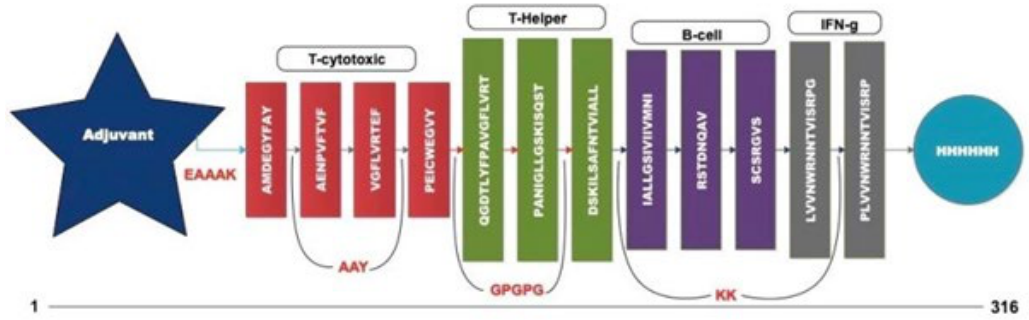
Fig. 4. Multi-epitope vaccine construct